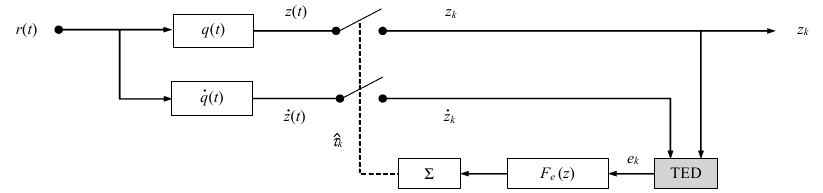
Figure 3. Dual-filter framework for symbol timing recovery.